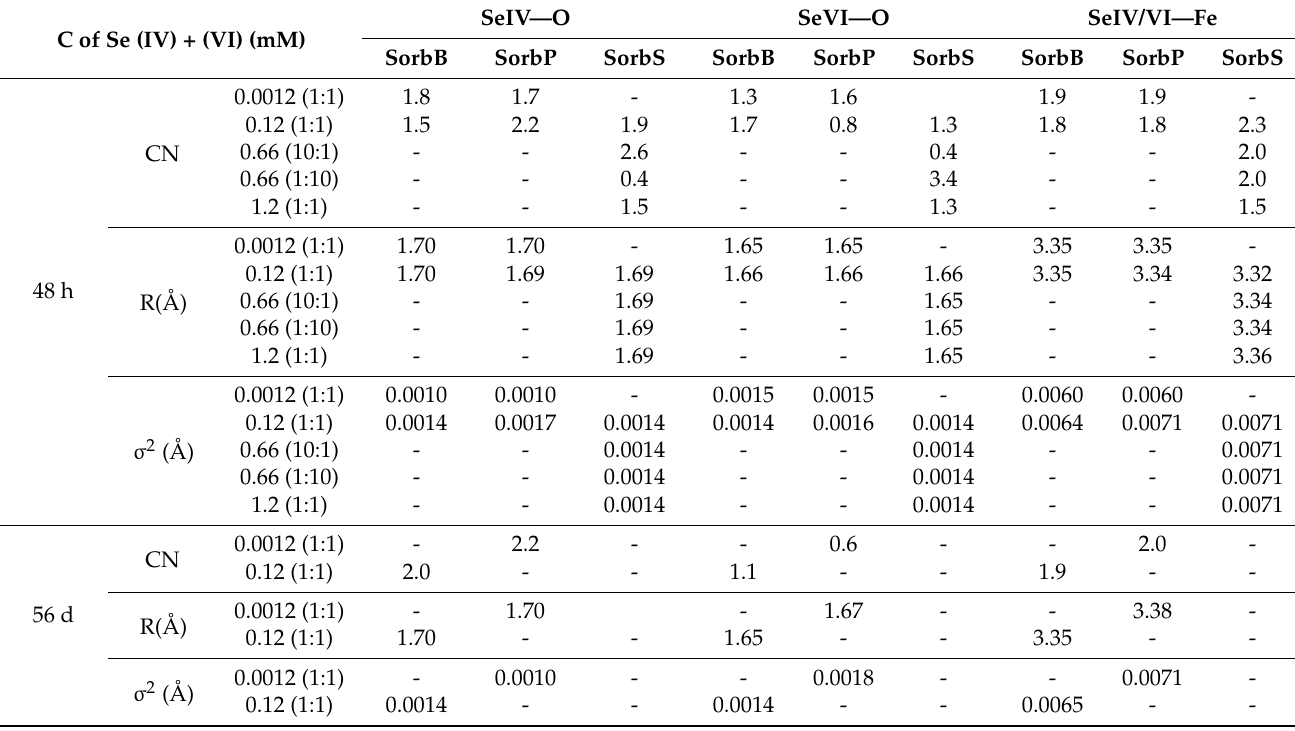
Table 3. Structural parameters of Se(IV) and Se(VI) adsorbed on SorbB, SorbP and SorbS at initial Se concentration of 0.0012, 0.12, 0.66 and 1.2 mM after 48 h derived from the EXAFS spectrum fitting. C of Se (IV) + (VI)